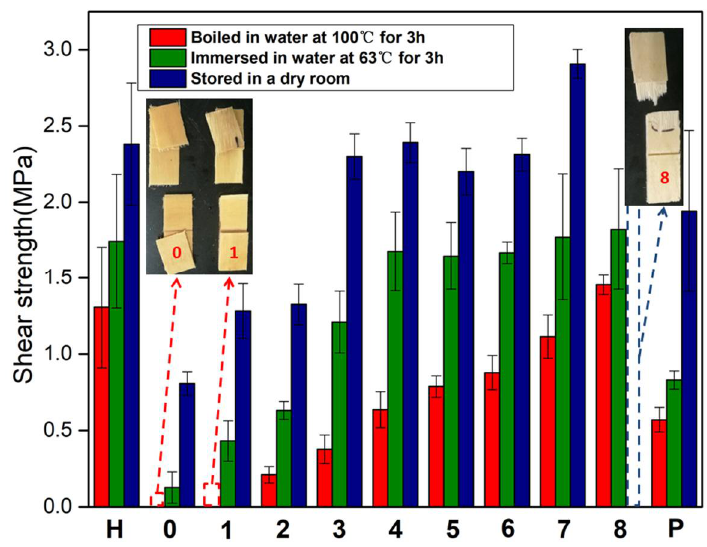
Figure 4. Shear strengths of the plywood bonded with the different adhesives: H (HMP adhesive), 0 (SF adhesive), 1 (SF/3% HMP adhesive), 2 (SF/6% HMP adhesive), 3 (SF/9% HMP adhesive), 4 (SF/12% HMP adhesive), 5 (SF/15% HMP adhesive), 6 (SF/18% HMP adhesive), 7 (SF/21% HMP adhesive), 8 (SF/24% HMP adhesive), and P (SF/PAE adhesive).